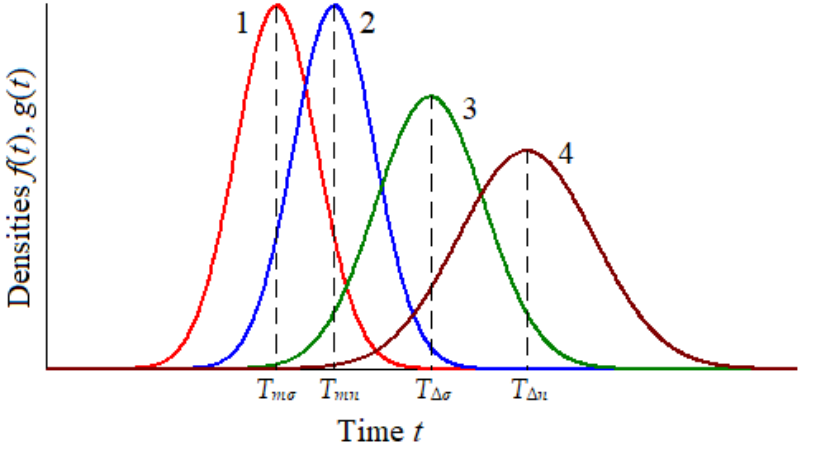
Figure 2. Distribution densities of fail-safe and prevention: 1 is g σ ( t ); 2 is g n ( t ); 3 is f σ ( t ); 4 is f n ( t ).